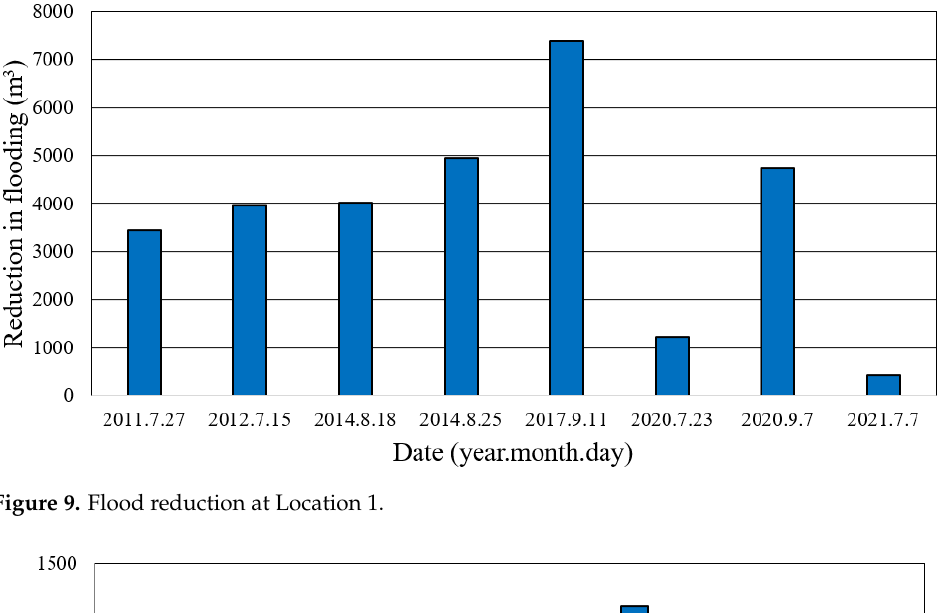
Figure 9. Flood reduction at Location 1.